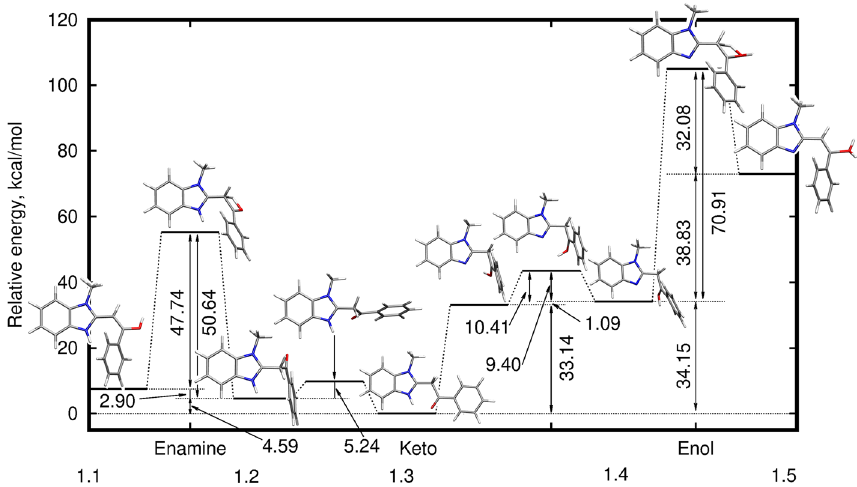
Figure 4. Mechanism of possible proton transfer processes in [ 1 +H ] + ion calculated within the ω B97X-D/6- 311++G(d,p)